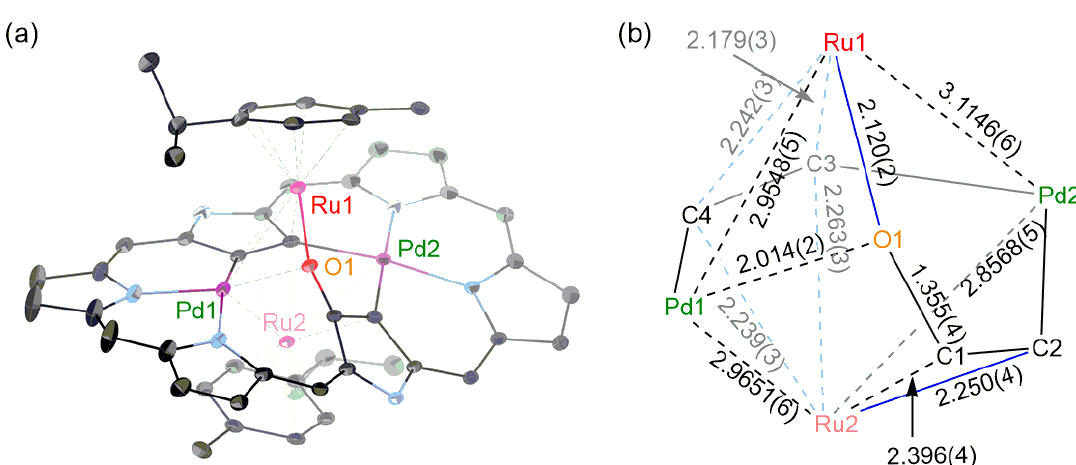
Scheme 2. Synthesis of 6 . meso -Pentafluorophenyl groups are omitted for clarity.